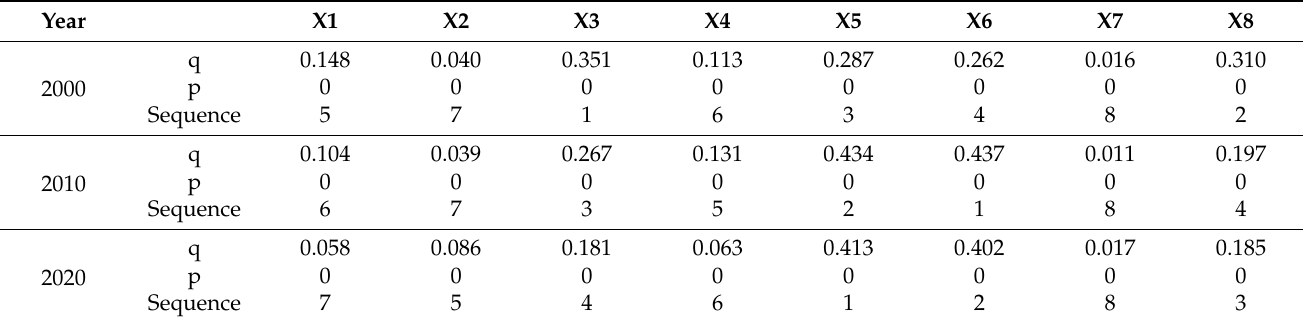
Table 5. The patterns of interaction